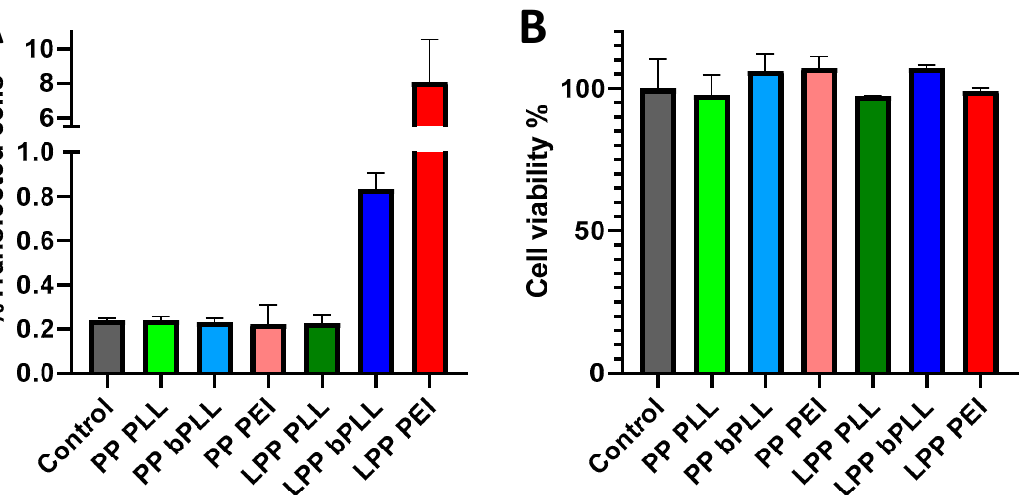
Figure 3. Flow cytometry evaluation of A549 cell transfection in 2D monolayer cell culture 3 d after incubation with PPs and LPPs ( A ); Resazurin viability assay of A549 cells incubation with PPs and LPPs for 24 h ( B ). Data are Means ± SD, n = 3.